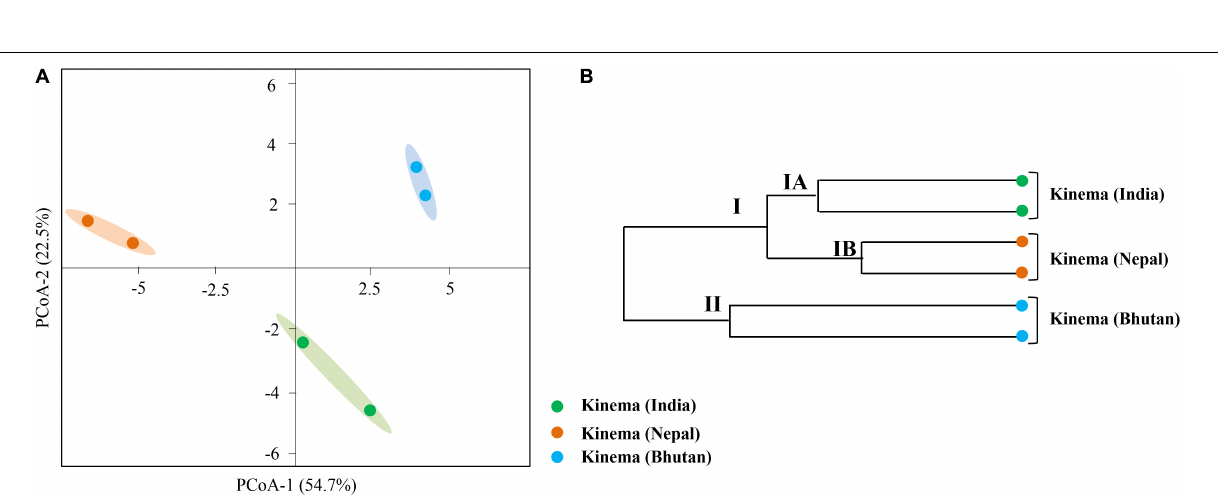
Frontiers in Microbiology |